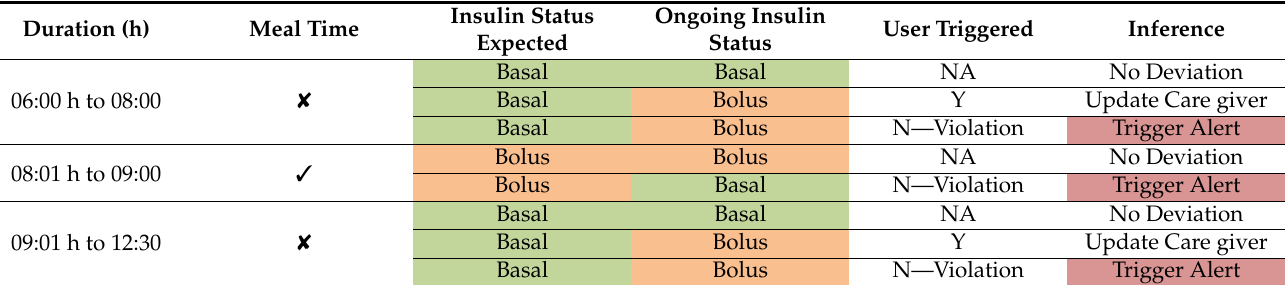
Table 3. State Table: Behavior states of IoT insulin